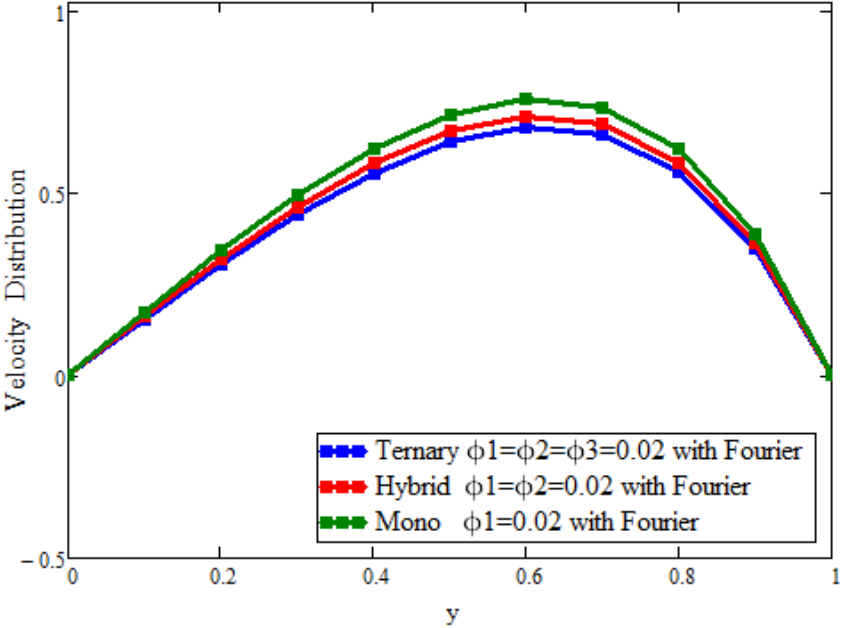
Figure 3. Comparison of velocity field assessments across y for the volumetric fraction of φ 1 = φ 2 = φ 3 = 0.02, where α = β = γ = 0.5, t = 1.1, Gr = 15, Pr = 21, a = 0.02, and M = 1.2.